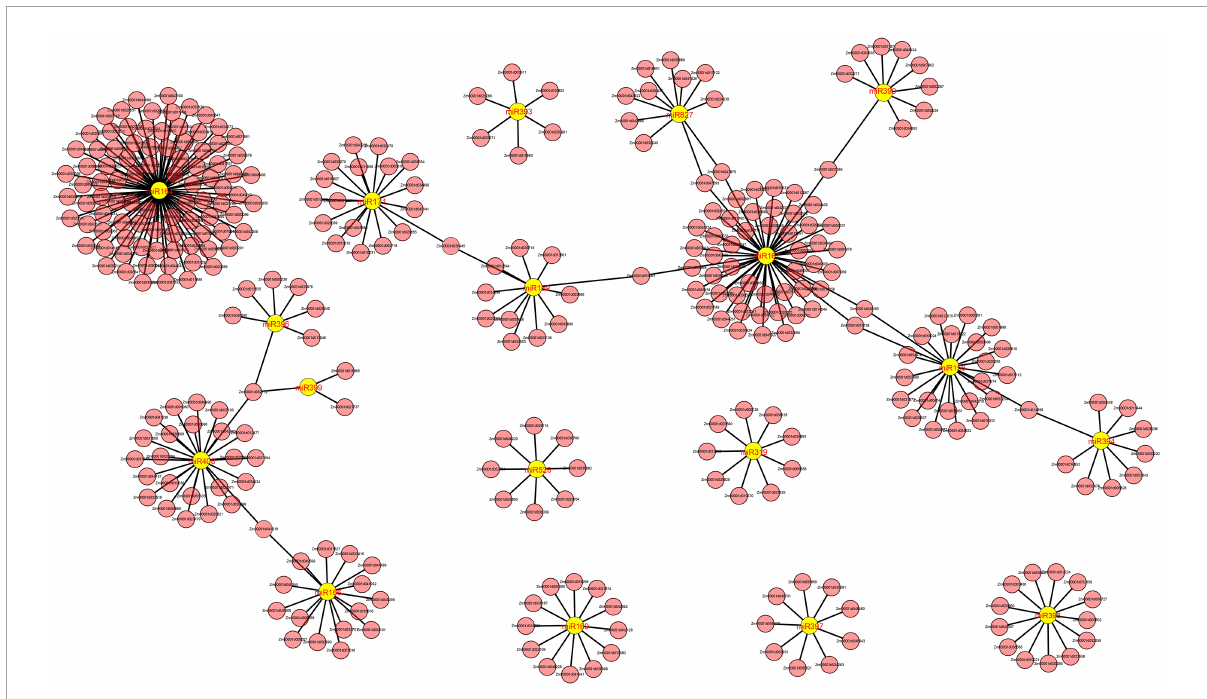
FIGURE3 Cystoscope regulatory networks of DEMIs and DEGs. Yellow graphics represent miRNAs, and pink graphics represent genes.